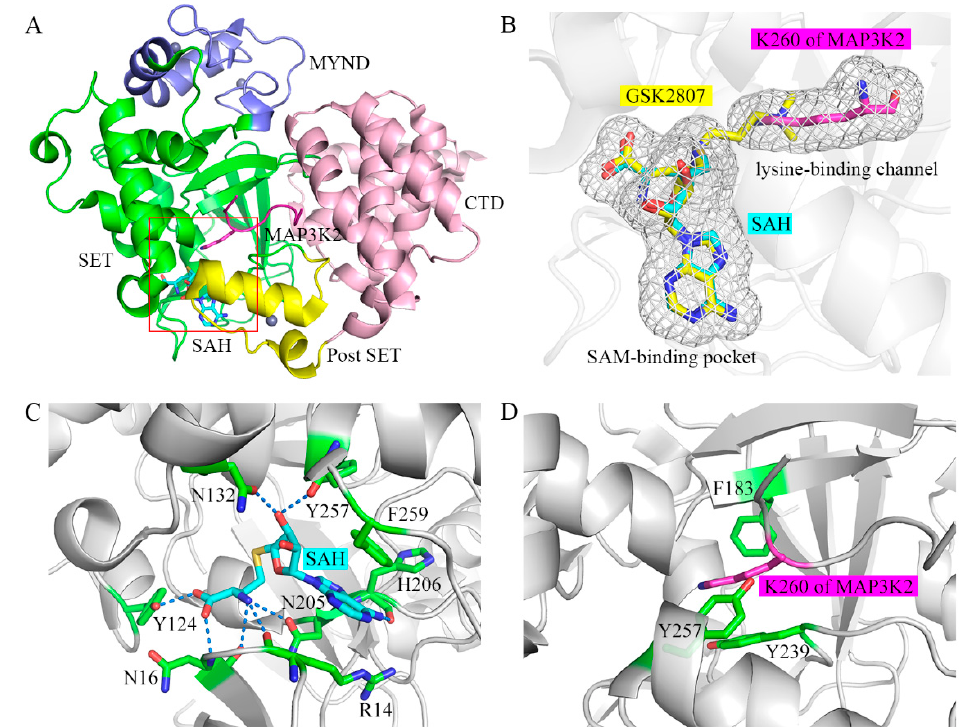
Figure 1. Overall structure of the SAM-binding pocket and the lysine-binding channel in SMYD3. ( A ) Crystal structure of SMYD3 in complex with substrate peptide and cofactor SAH (PDB: 5EX0). The SET, MYND, post-SET, and C-terminal domains of SMYD3 are shown in green, blue, yellow, and pink, respectively. SAH and the MAP3K2 peptide are shown as cyan and magenta sticks, respectively. Zinc ions are shown as grey spheres. The SAM-binding pocket and the lysine-binding channel are highlighted in the red box. ( B ) Magnified view of the SAM-binding pocket and the lysine-binding channel. GSK2807 is shown as yellow sticks. ( C ) Binding mode of SAH in the SAM-binding pocket. Residues in SMYD3 are shown as green sticks. The hydrogen bond is depicted as a dashed line. ( D ) Binding mode of the target lysine residue in the lysine-binding channel.